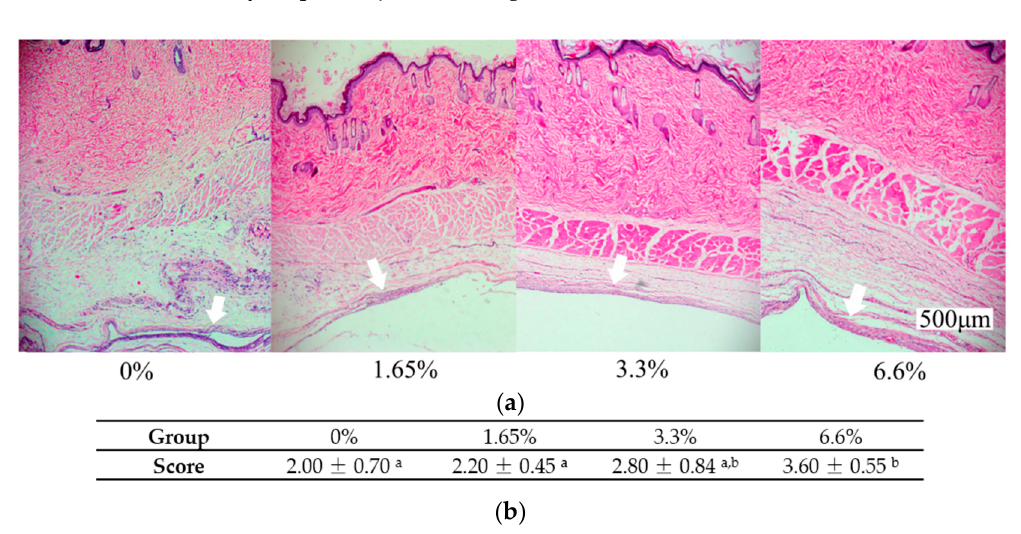
Figure 5. The representational images of tissue surrounded the implanted material as well as inflammatory response scores: ( a ) Representational images of tissue surrounded implanted material after eight days were all captured with a 4× objective lens and the white arrows showed the interface where tissue contacted to the material directly; ( b ) Inflammatory response scores of different groups. Values are significantly different when labelled with different letters ( p < 0.05).